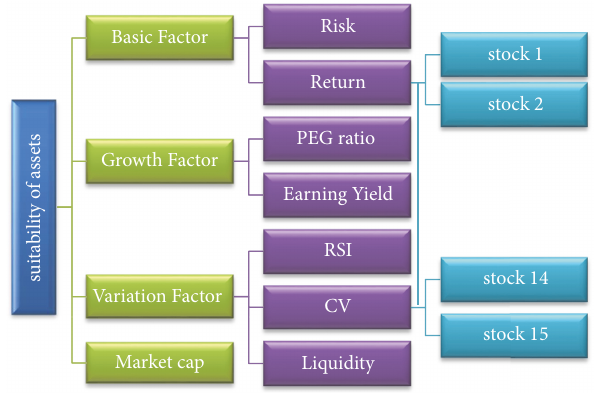
Figure 1: Hierarchy